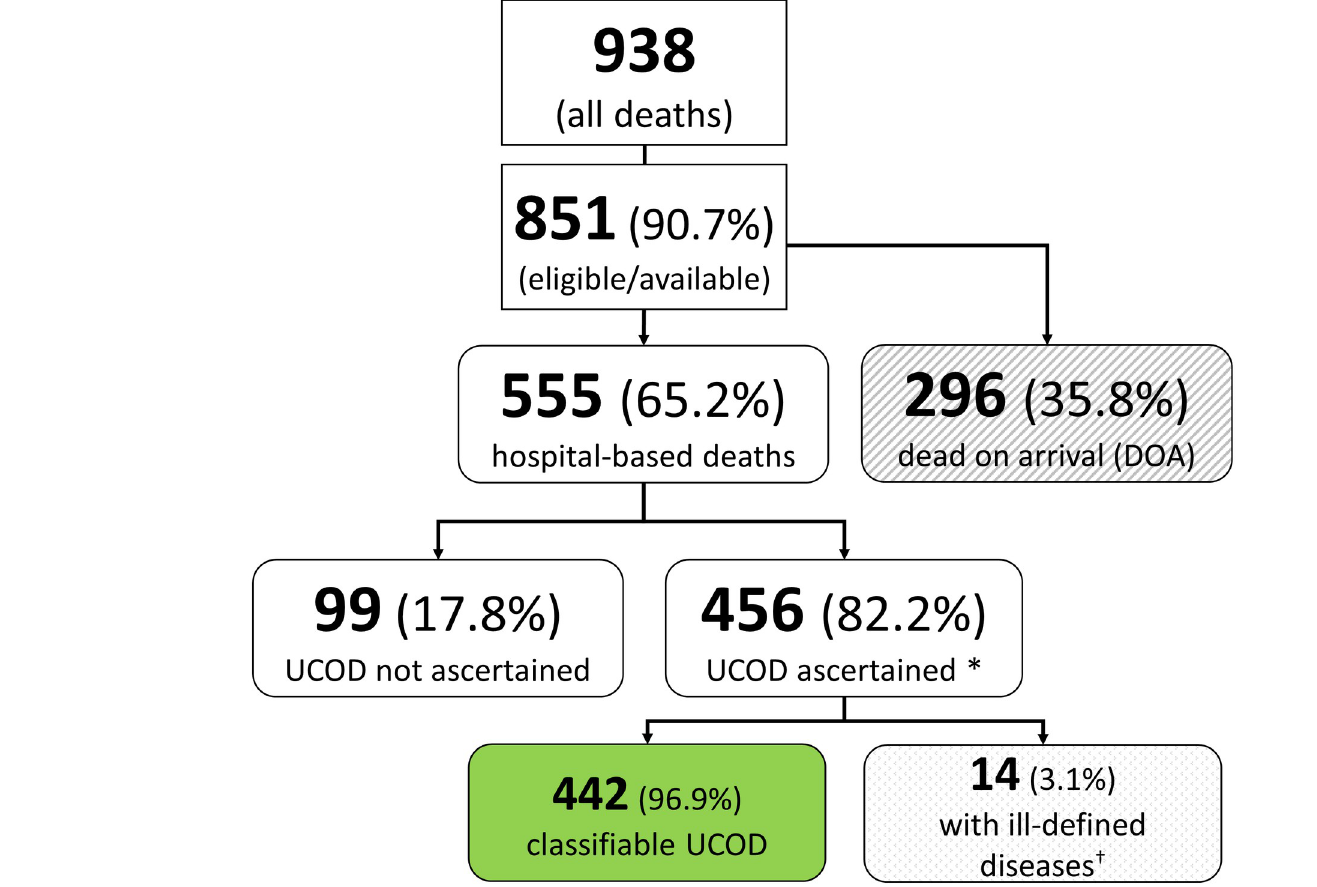
Fig 1. Deaths of hospitalized patients at two referral hospitals, Kisumu County, Kenya (2019). The figure presents the data flow for the study and the analysis for this manuscript.